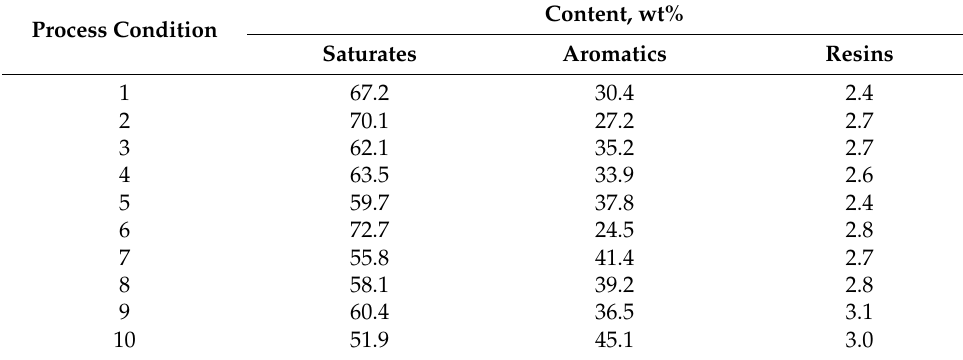
Table 6. Feedstock composition to define the model